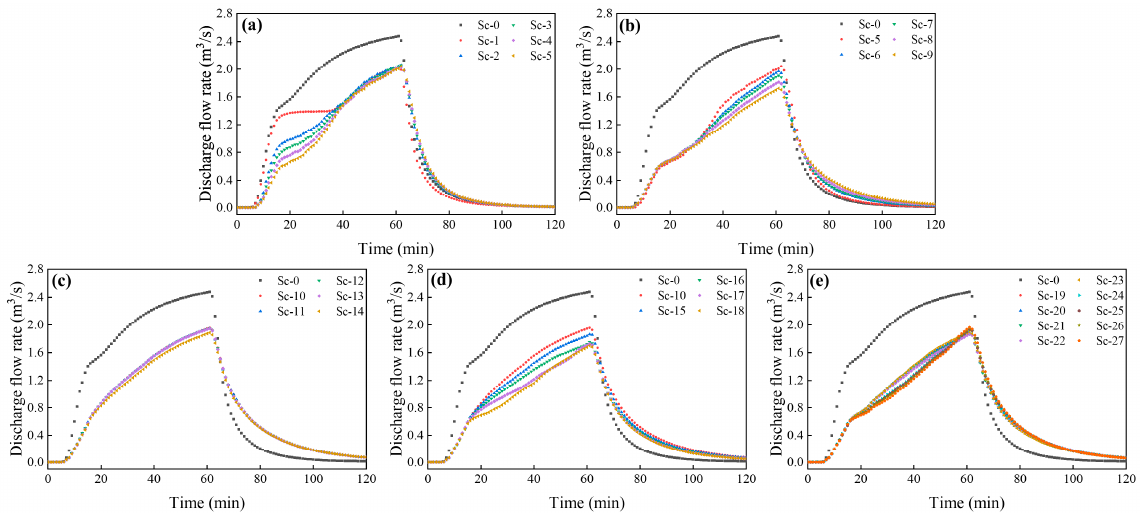
Figure 15. The time series plot of DFR in 1 h event in considered scenarios of ( a ) connectedness of GR; ( b ) connectedness of RG; ( c ) edge density of GR; ( d ) edge density of RG; ( e ) flow distance of RG.